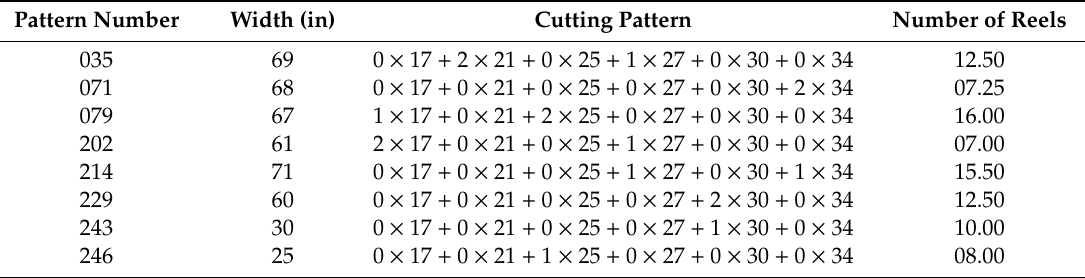
Table 4. Non-integer optimal solution.